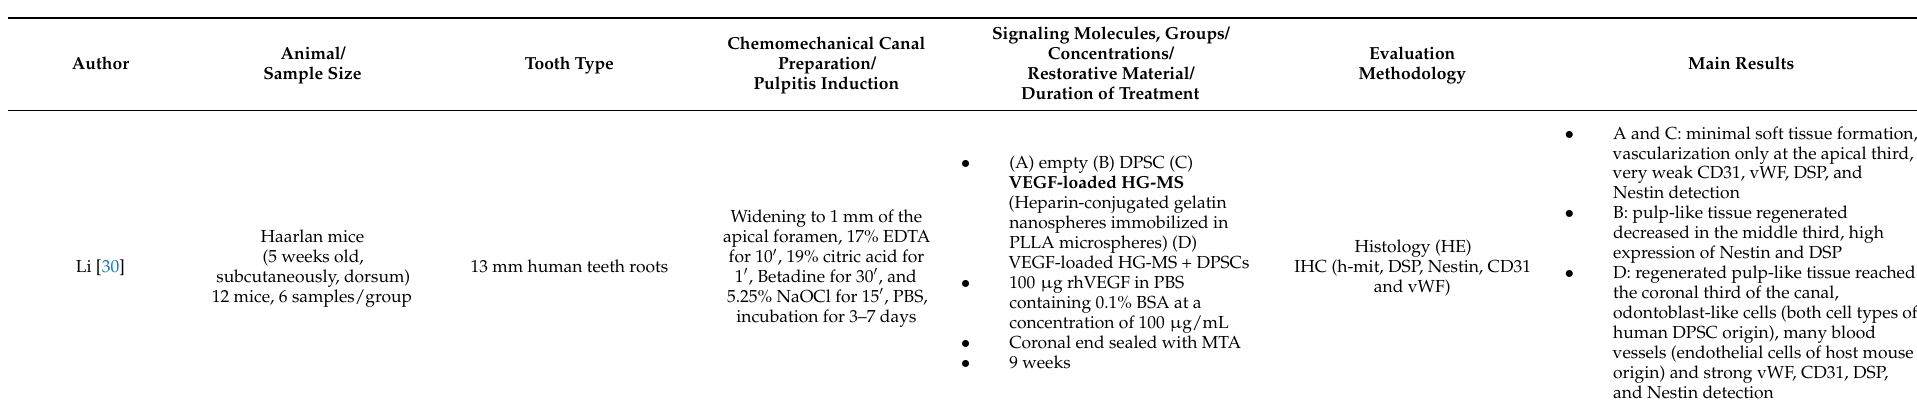
Table 3. Ectopic animal studies *. The studied signaling biomolecules are indicated in